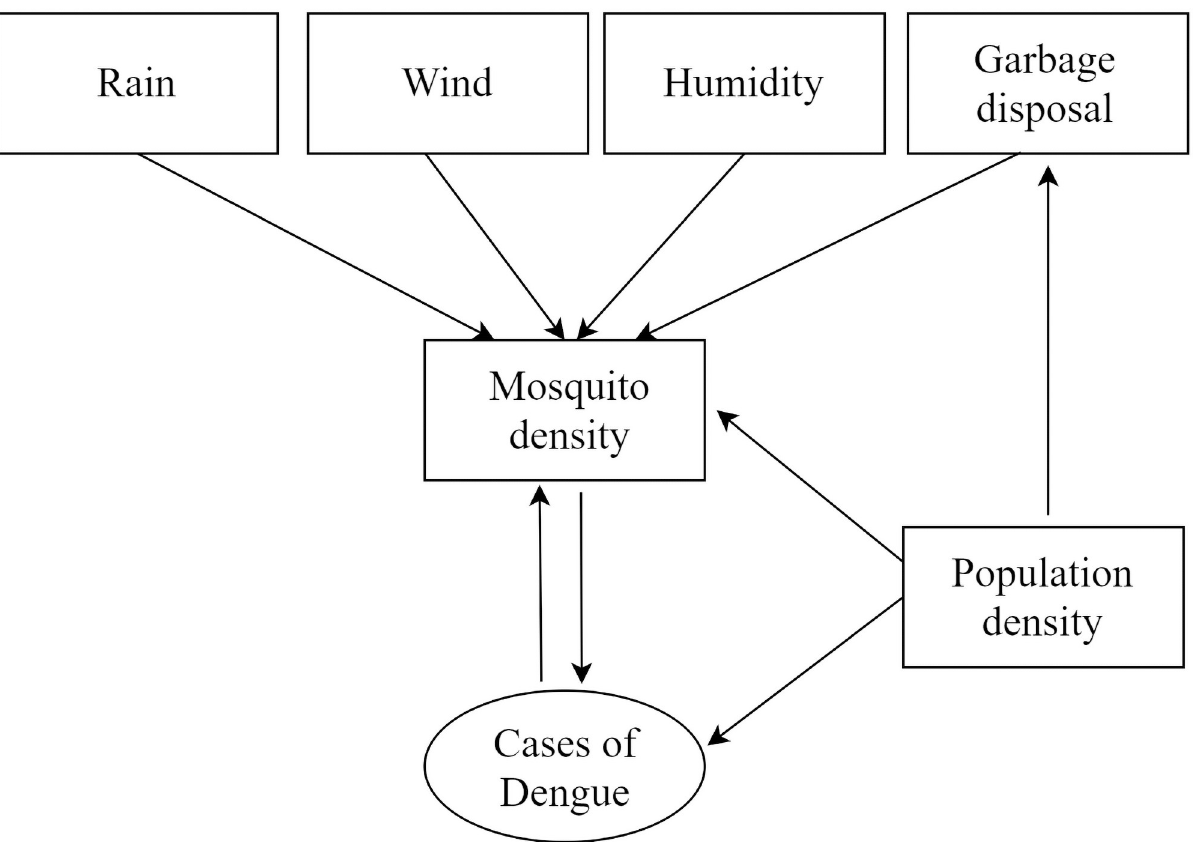
Fig 1. The relationships between the factors effecting the number of dengue